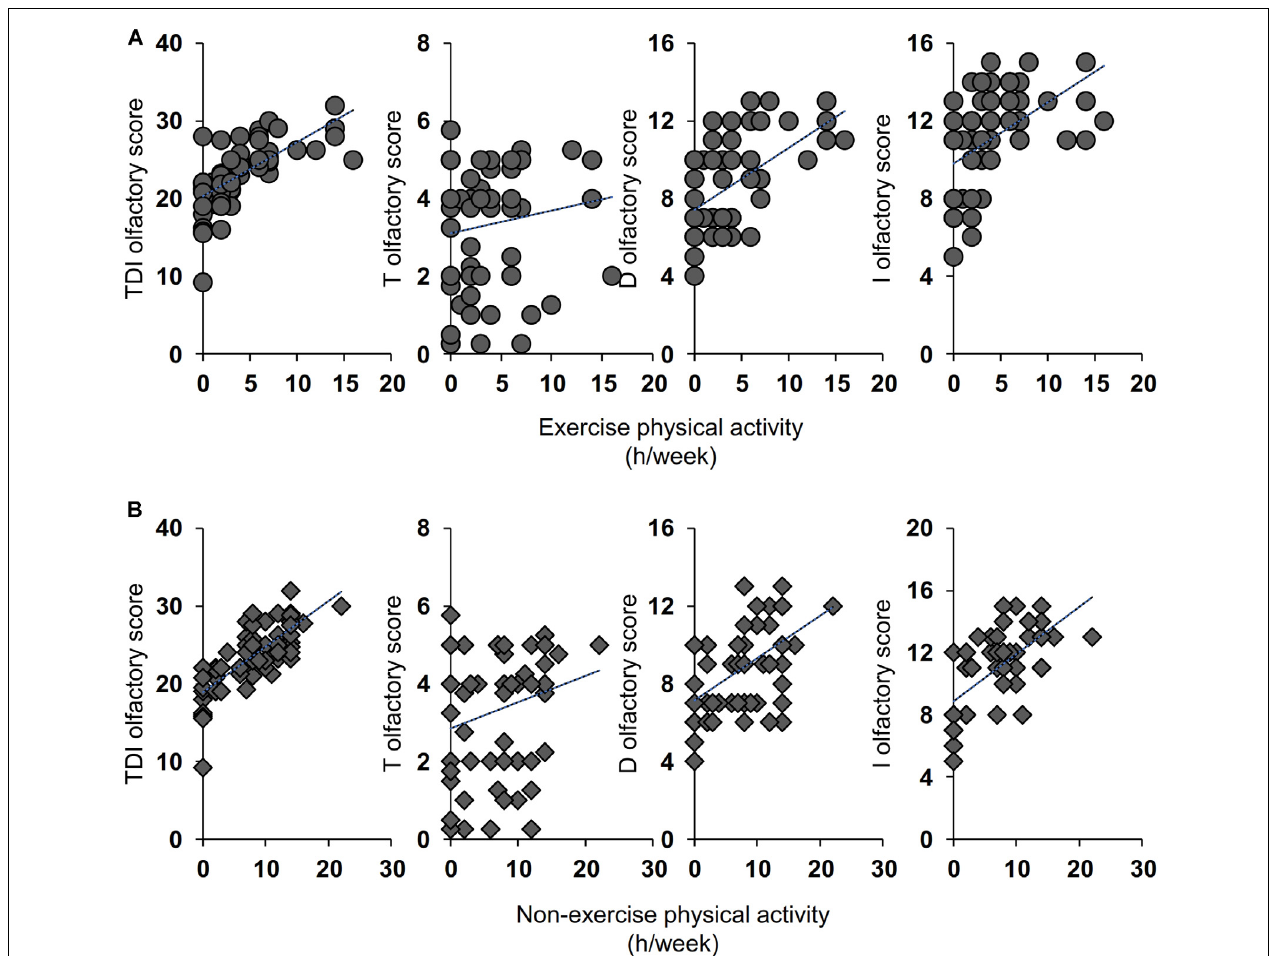
FIGURE 3 | Correlation analysis between the TDI, T, D, and I olfactory score and the number of hours per week (h/week) dedicated by each inactive ES to the exercise (A) and non-exercise (B) physical